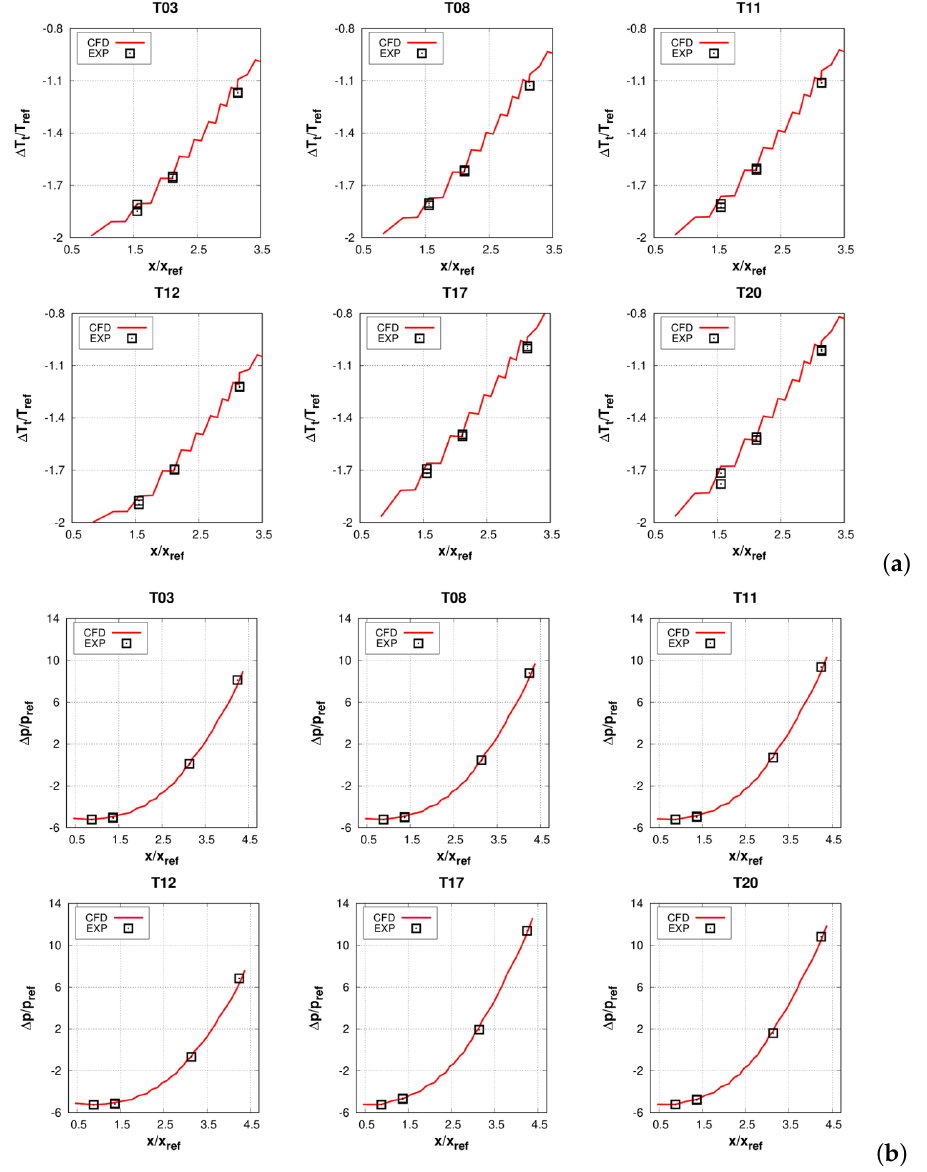
Figure 7. Measured and predicted total temperature ( a ) and static pressure ( b ) distributions at casing for the six configurations experimentally tested by Ansaldo Energia